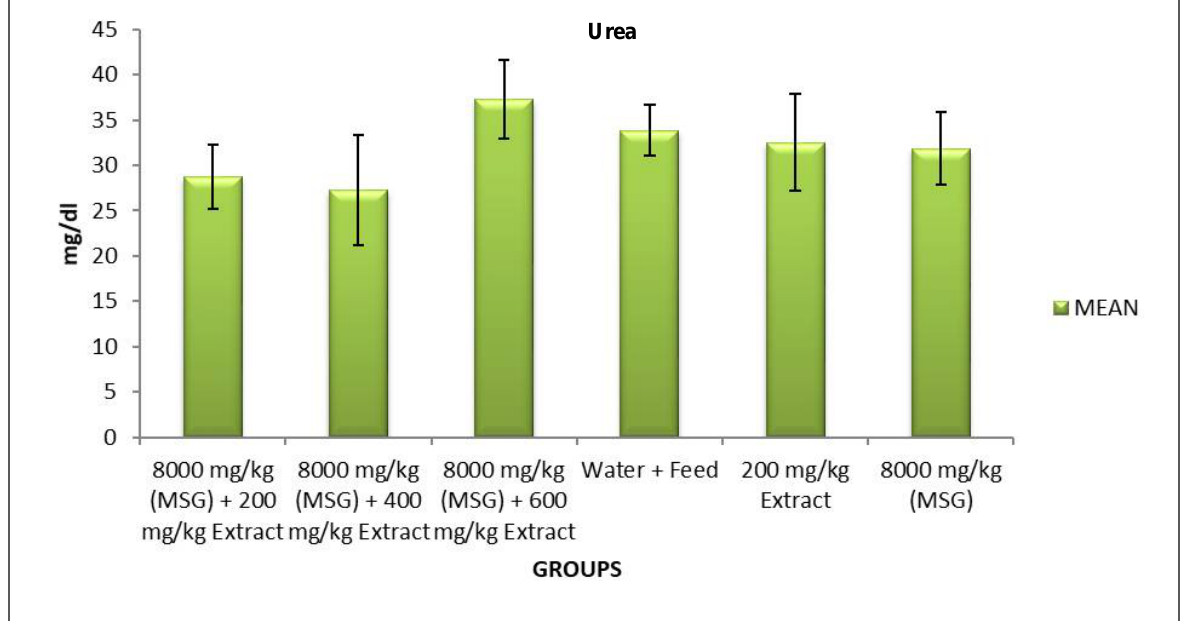
Figure 7: Effect of methanol extract of N. laevis on Urea concentration (mg/dl) of female